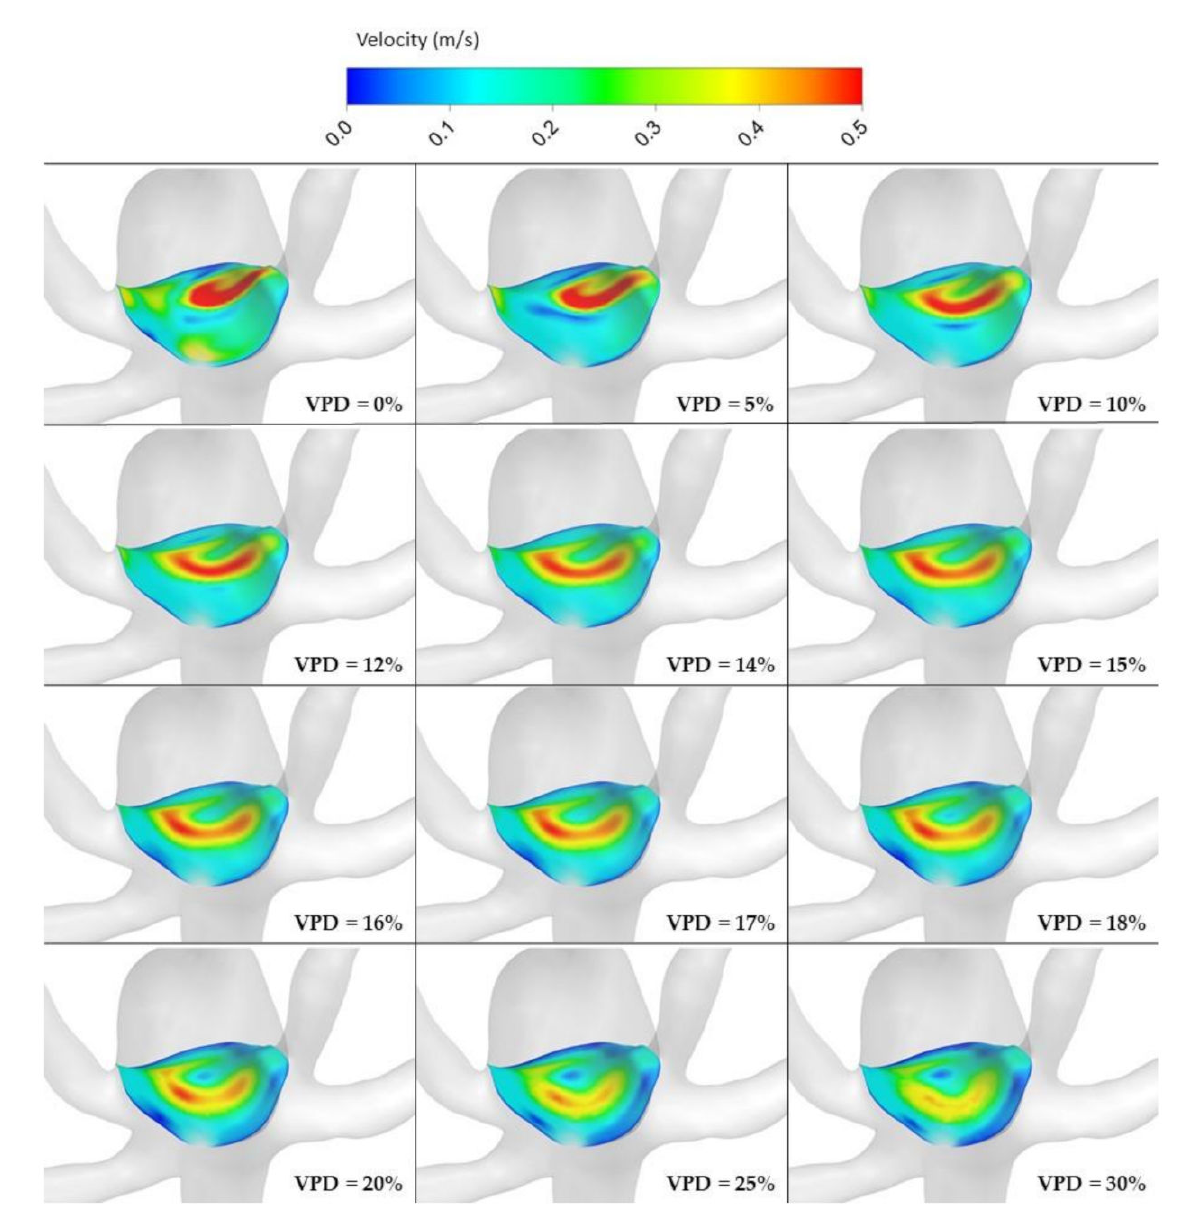
Figure 13. Velocity distribution at aneurysm neck for selected VPD cases; stationary